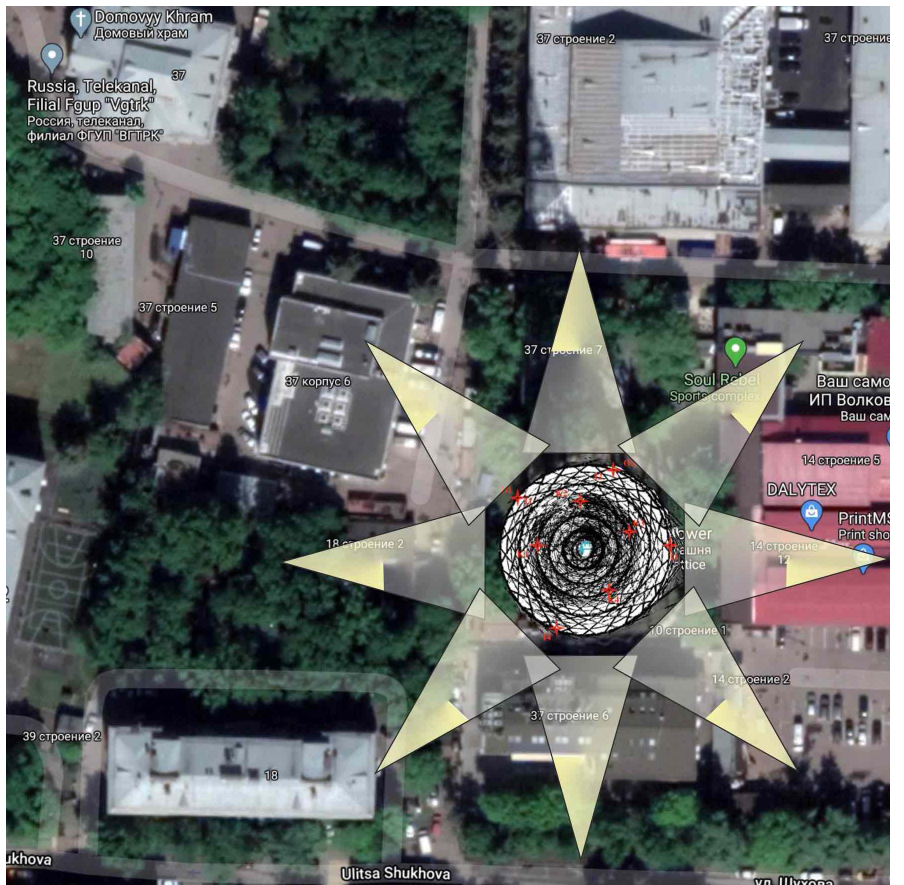
Figure 4. A scheme of imaging directions (’8-ray star’) and marker